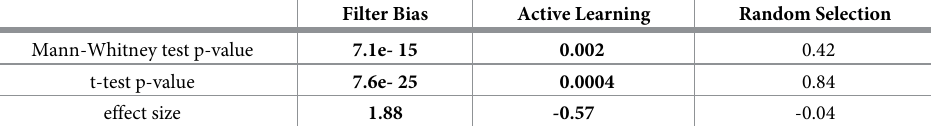
Table 15. Results of the Mann-Whitney U test and the t-test comparing the boundary shift for the three forms of iterated algorithmic bias with the Movielens data set. The positive effect size indicates that filter bias leads to fewer points predicted to be in class y = 1. Random selection and active learning do not have a significant